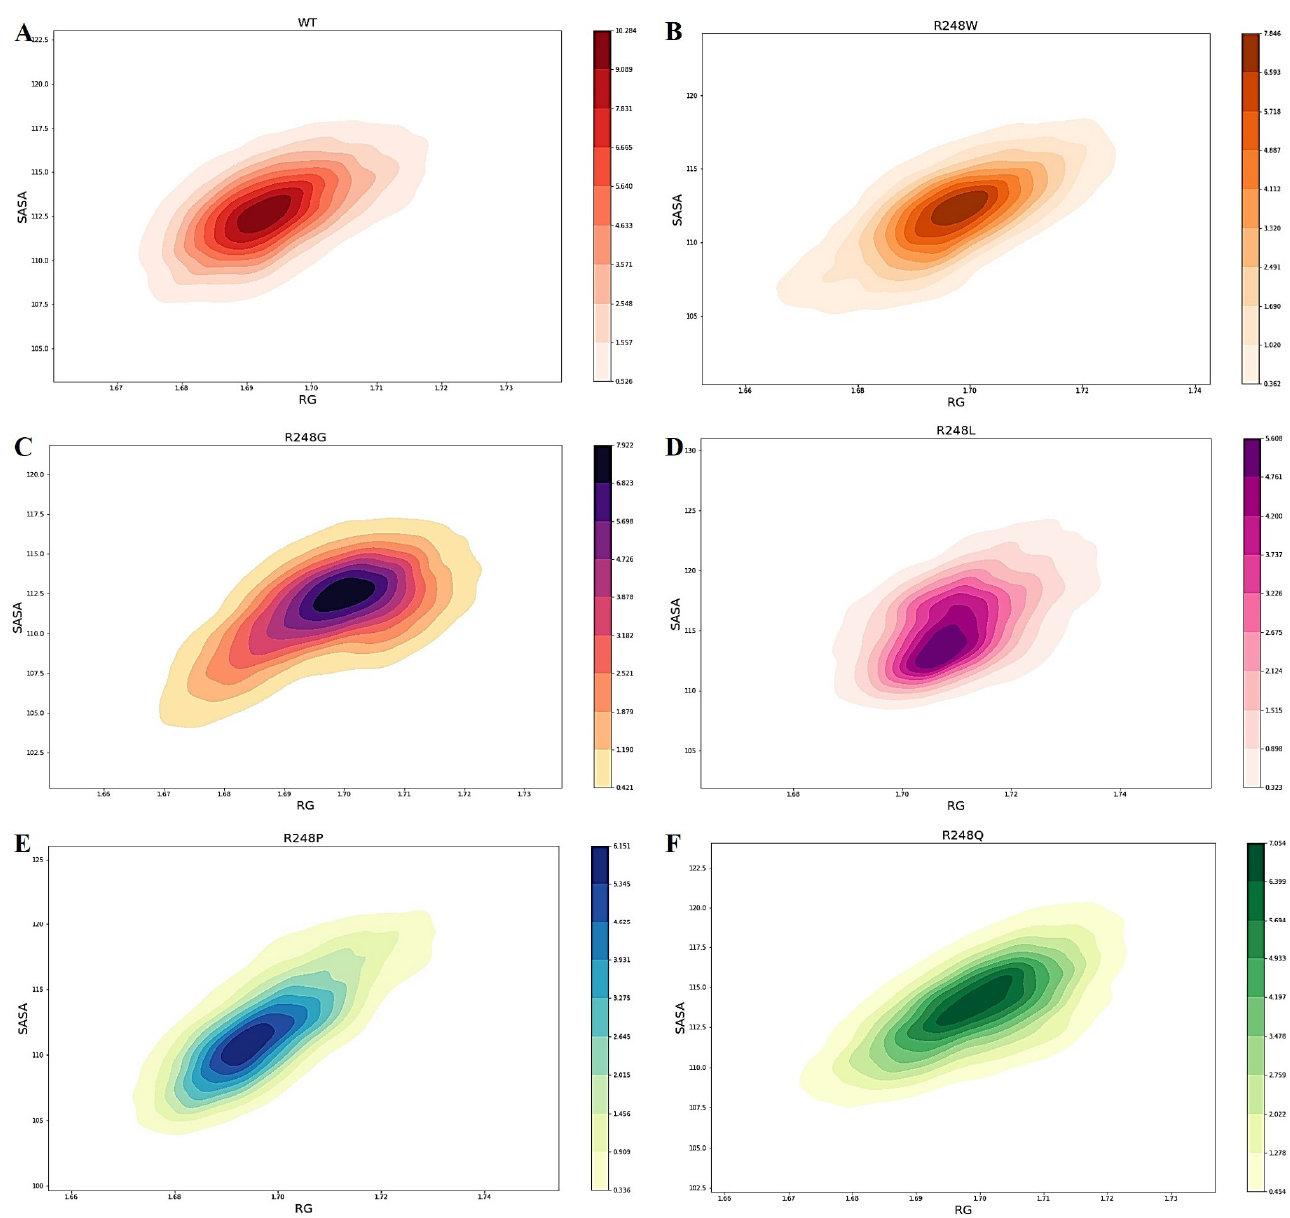
Figure 6. The kernel density estimation (KDE) plots of Rg and SASA were used as collective variables to visualize the conformation of the wt-p53–DNA complex and R248 mutant-p53–DNA complexes during the MD simulation. Rg (nm) is shown on the X-axis, while SASA (nm 2 ) is depicted on the Y-axis. ( A ) The wt-p53–DNA complex, ( B ) the R248W mutant-p53–DNA complex, ( C ) the R248G mutant-p53–DNA complex, ( D ) the R248L mutant-p53–DNA complex, ( E ) the R248P mutant-p53–DNA complex, and ( F ) the R248Q mutant-p53–DNA complex.